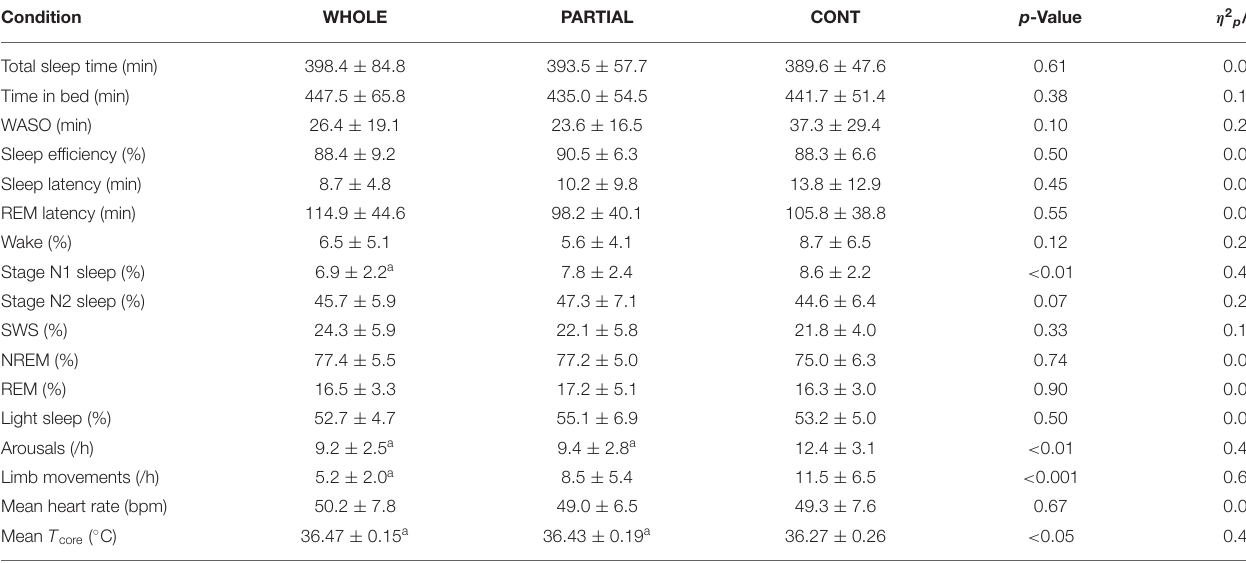
TABLE 1 | Polysomnography analysis, mean nocturnal heart rate, and T core during the whole night in WHOLE ( n = 12), PARTIAL ( n = 12), and CONT ( n = 10) conditions.